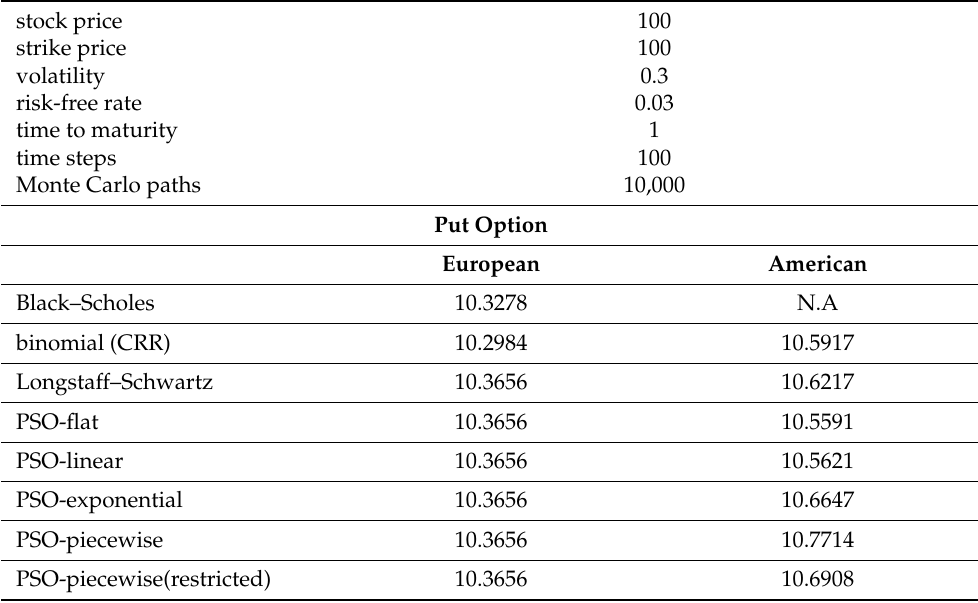
Table 1. American put results taken from crr3d.xls. The option payoff is: max { K − S } ,0 }